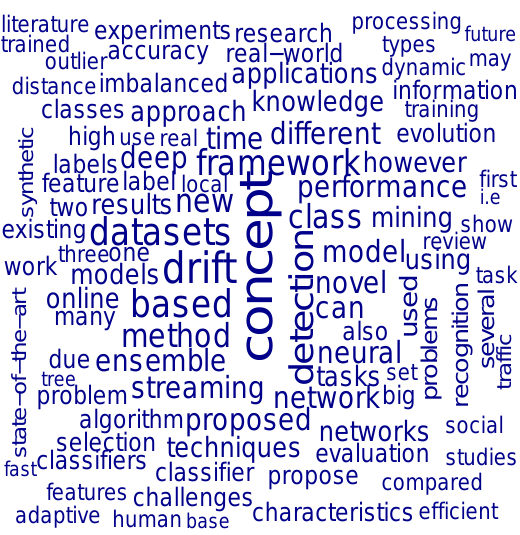
Figure 10. Wordcloud of titles and abstracts of papers published in 2020 and